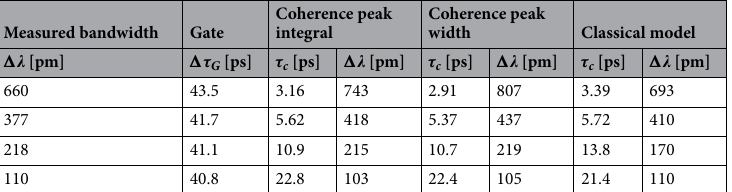
Table 1. Retrieved pulsed ASE source parameters. The pulse duration �τ G is deducted from the gate autocorrelation Q (τ) and the coherence time τ c is evaluated through 3 approaches: integration of the coherence 1 + | g ( 1 ) (τ) | 2 peak i.e. Eq. (5) (column 3), extraction from the coherence peak width (column 5) and best fit of the classical model (column 7). The corresponding ASE bandwidth is also given and can be compared to the (cid:31) (cid:30) measured spectral bandwidth.